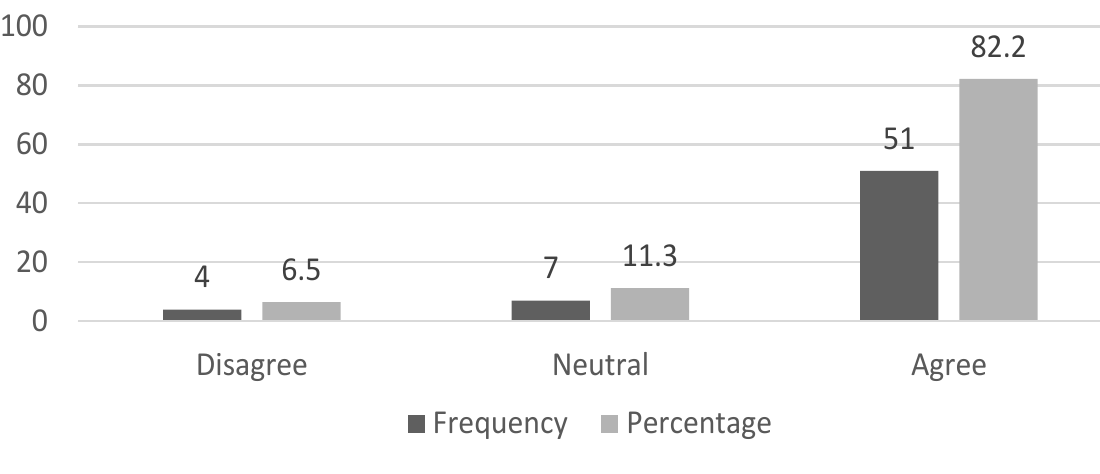
Figure 3. Availability of FMPs for